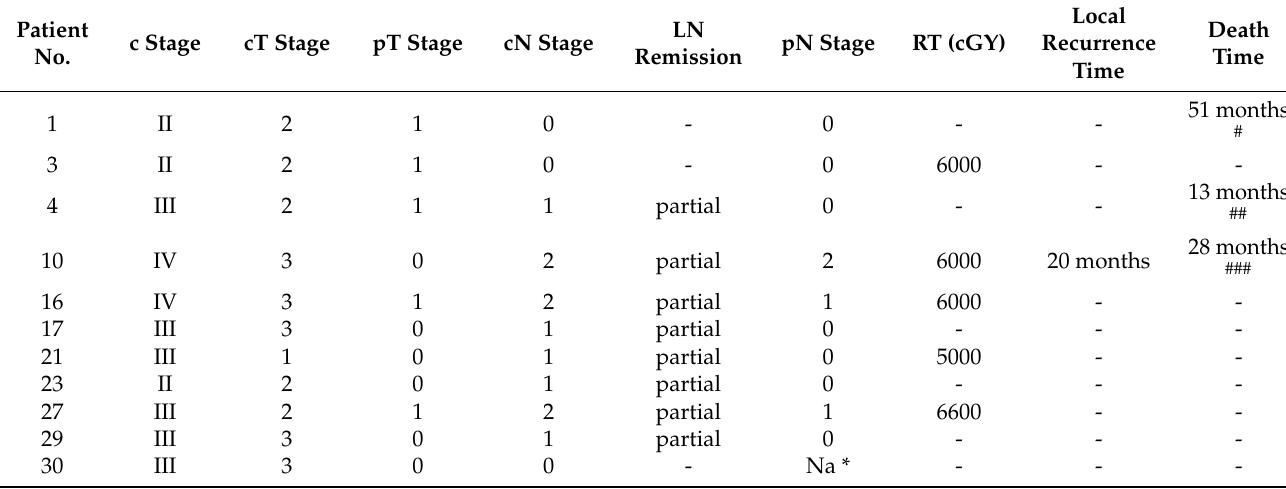
Table 2. Clinical/pathologic T & N stages for 11 patients of hypopharyngeal cancer receiving neoadjuvant chemotherapy and their post-TORS management and follow-up